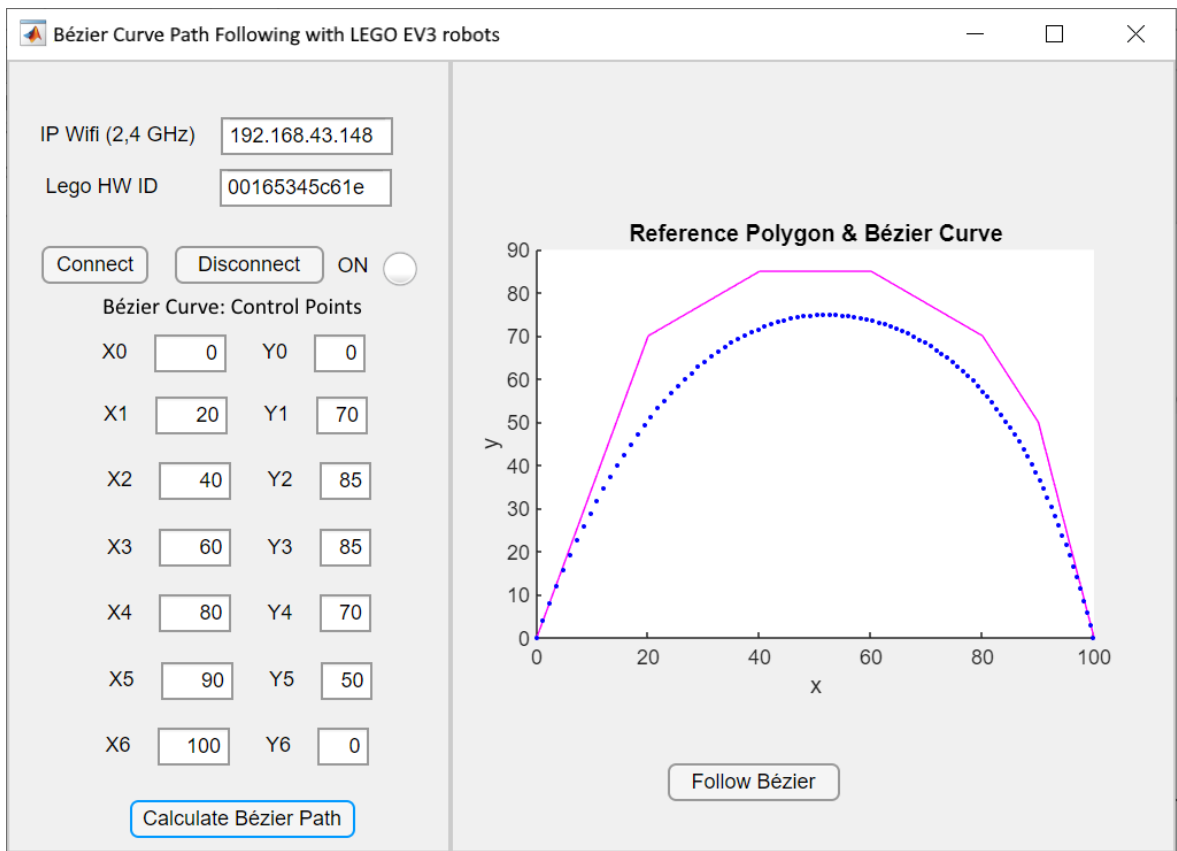
Figure 4. Matlab Application for the LEGO EV3 robot control.